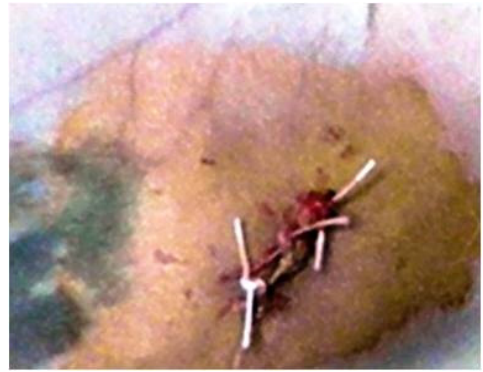
Figure 2. Wound suture after implant.